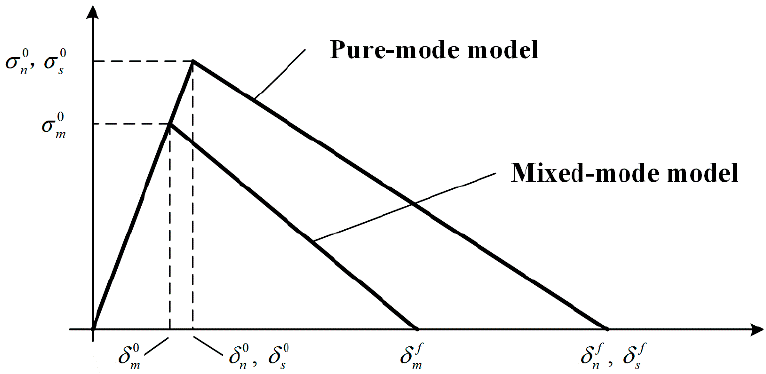
Figure 7. The traction–separation law with a linear softening law, available in Abaqus ® . Table 3. Cohesive parameters of the adhesive for the cohesive damage model. Property